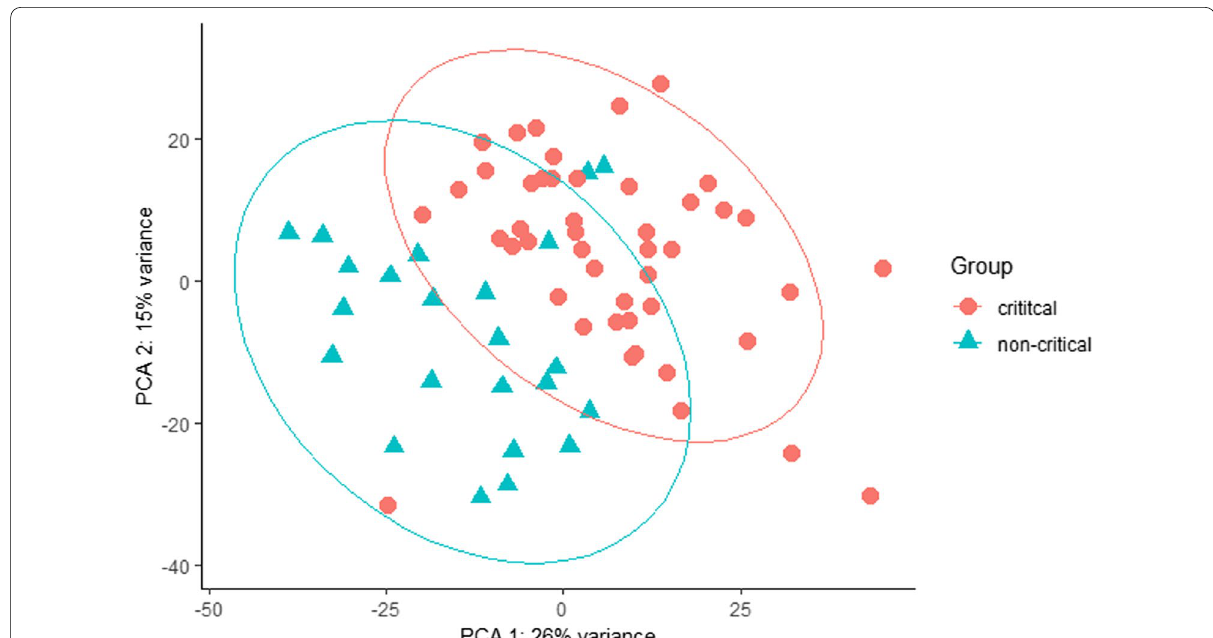
Fig. 1 Principal component analysis (PCA) showing segregation of critical and non-critical SARS-CoV-2-infected individuals. The “red” dots represent critical patients, and the “green” dots represent non-critical patients. The contribution of each PCA is shown on the X - and Y -axis where PCA 1 contributed 26% of the variance and PCA 2 contributed 15% of the total variance in the